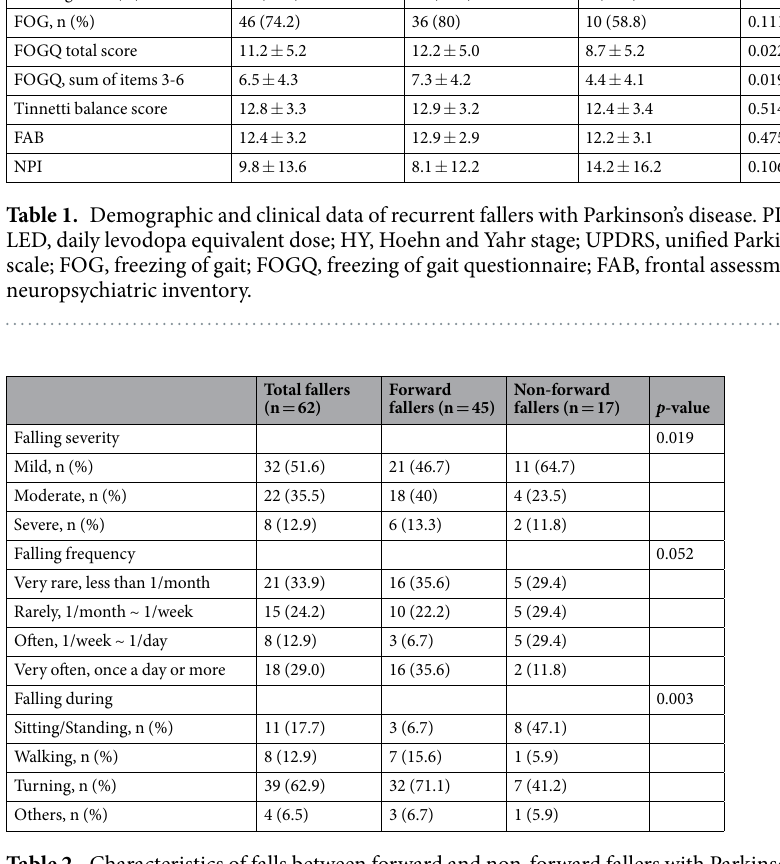
Table 2. Characteristics of falls between forward and non-forward fallers with Parkinson’s